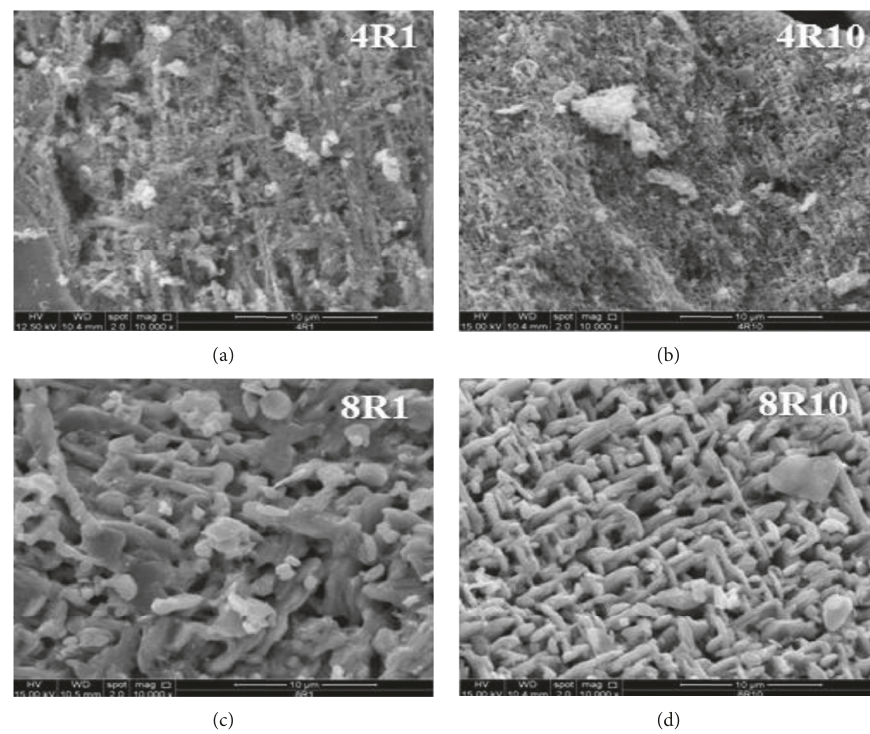
Figure 3: SEM micrographs of the materials synthesized at 400 ° C and 800 ° C and heating rates of 1 ° C/min and 10 ° C/min in both